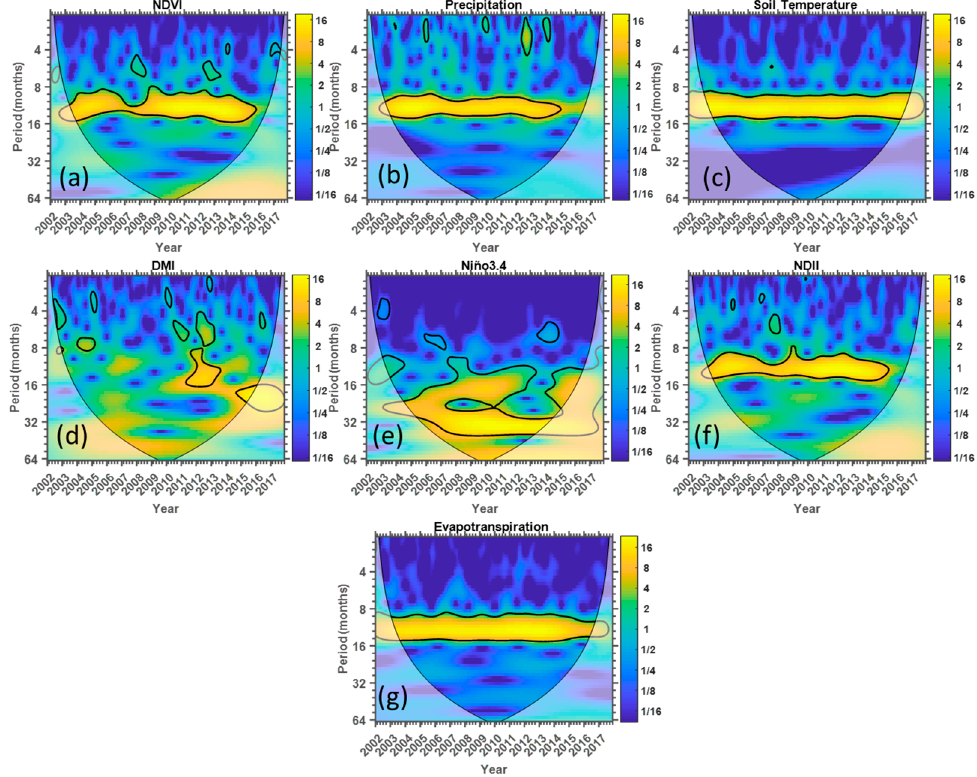
Figure 10. The normalized wavelet power spectra of monthly mean ( a ) NDVI, ( b ) precipitation, ( c ) Soil temperature, ( d ) DMI, ( e ) Niño3, ( f ) NDII, and ( g ) ET, plotted for the period from 2002 to 2017. The black lines which encircle the yellowish colors indicate the areas of significance at the 95% confidence level using the red noise model.